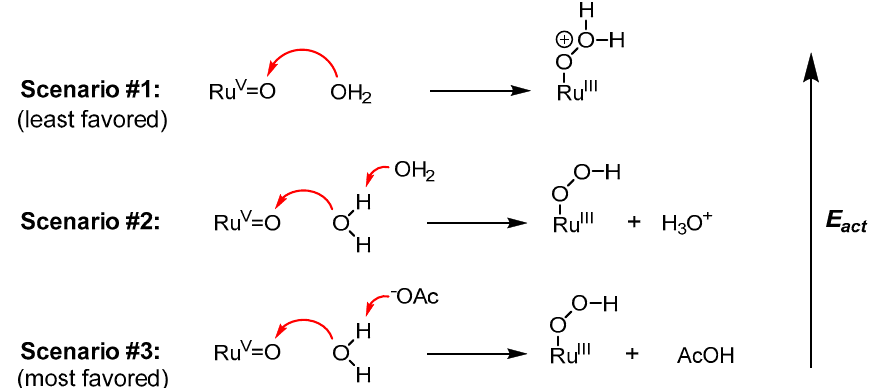
Figure 17. Relative energetics of an O-O bond formation by WNA.